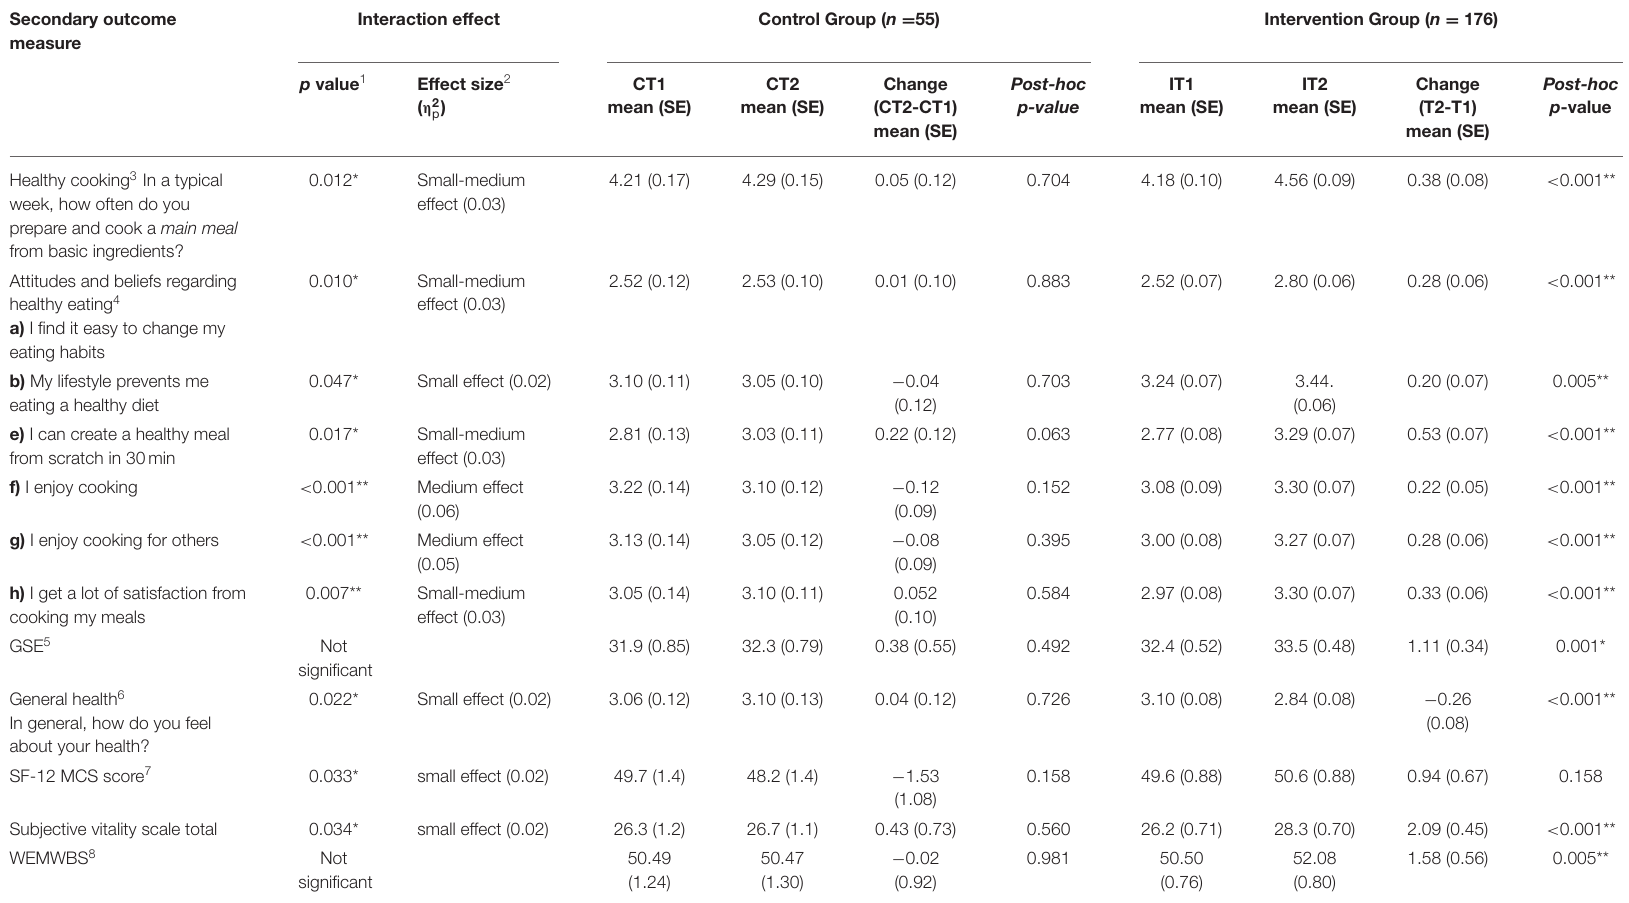
TABLE 3 | Multivariable-adjusted general linear models of program interaction effects over time on secondary outcome measures at T1 (baseline) and T2 (5/7-week follow-up) by